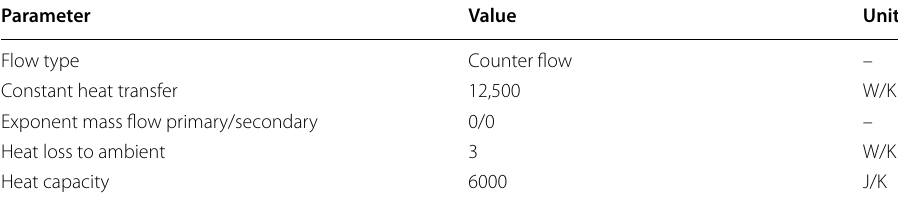
Table 1 Parameterisation of the HEx component